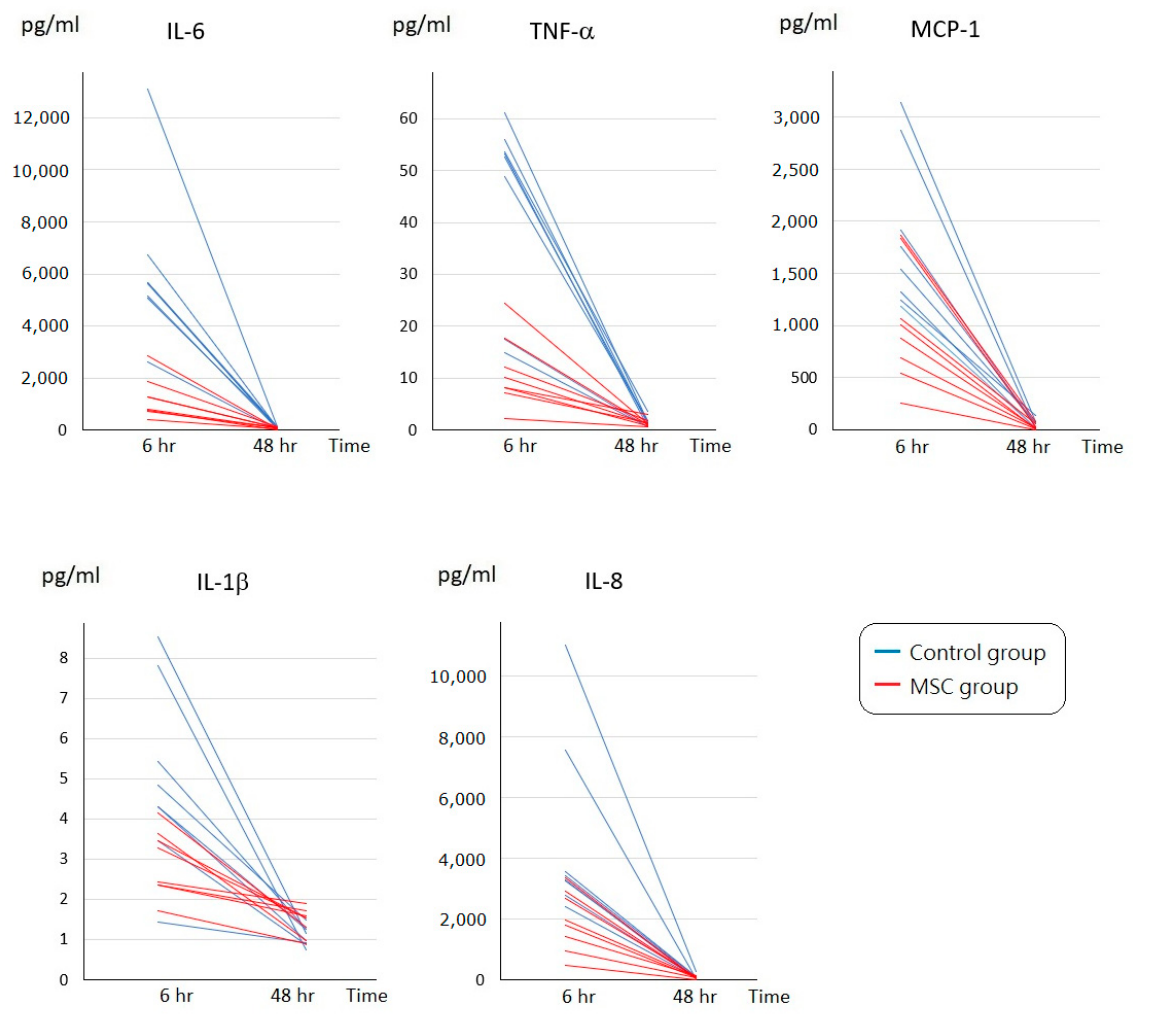
Figure 3. Time-series changes on circulating inflammatory cytokine levels of each individual mouse at 6 and 48 h after LPS-induced ALI. For IL-6, TNF- α , MCP-1, IL-1 β , or IL-8, the serum concentration of each individual mouse in either group declined to a similar level at 48 h after LPS challenge. n = 8 mice/group.